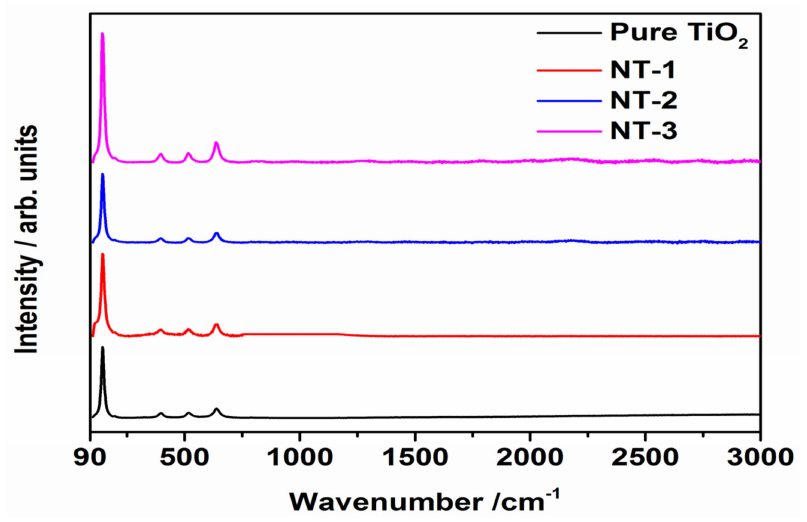
Figure 2. Raman spectra of pure TiO 2 , NT-1, NT-2 and NT-3, synthesized by using 0.0 g, 0.983 g, 1.965 g and 2.940 g of urea